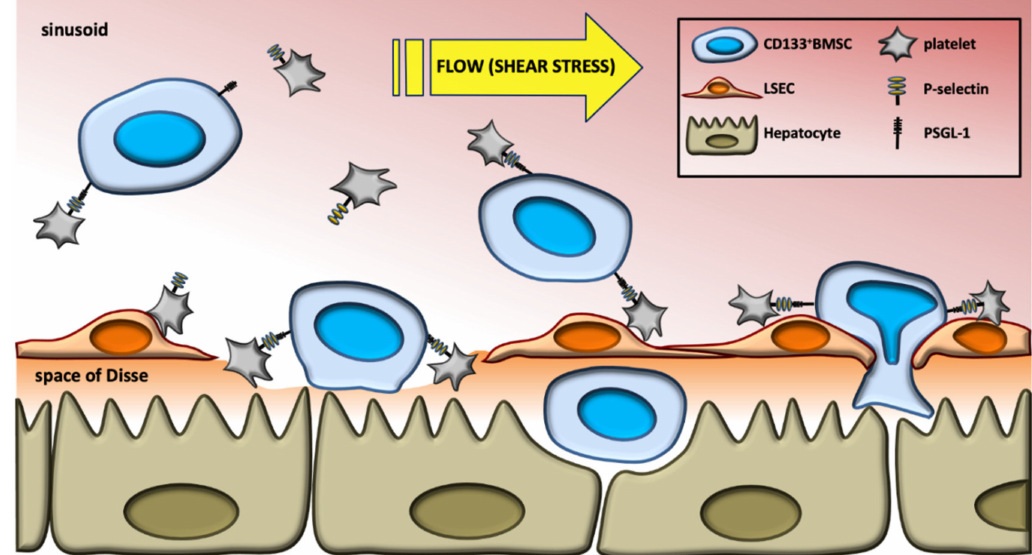
Figure 6. Model of platelets to increase hepatic homing of CD133 + BMSC to the injured liver. In response to shear stress in the liver, platelets promote sinusoidal adhesion of CD133 + BMSC and subsequent transmigration to the extra-sinusoidal space, both forwarded by P-selectin / PSGL-1